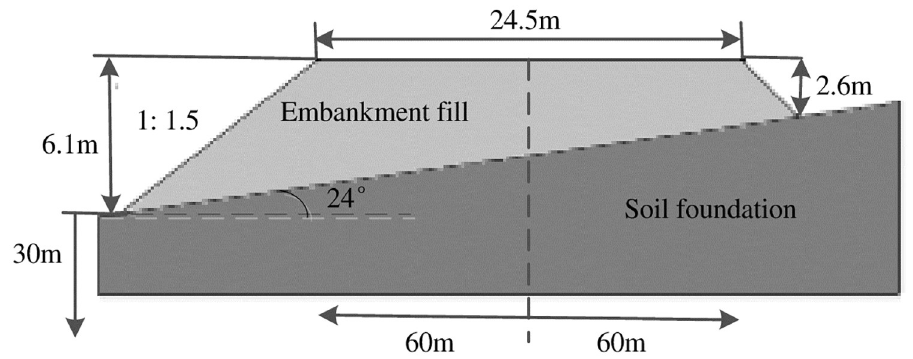
Fig 1. Finite difference model of the embankment fill-soil foundation system.